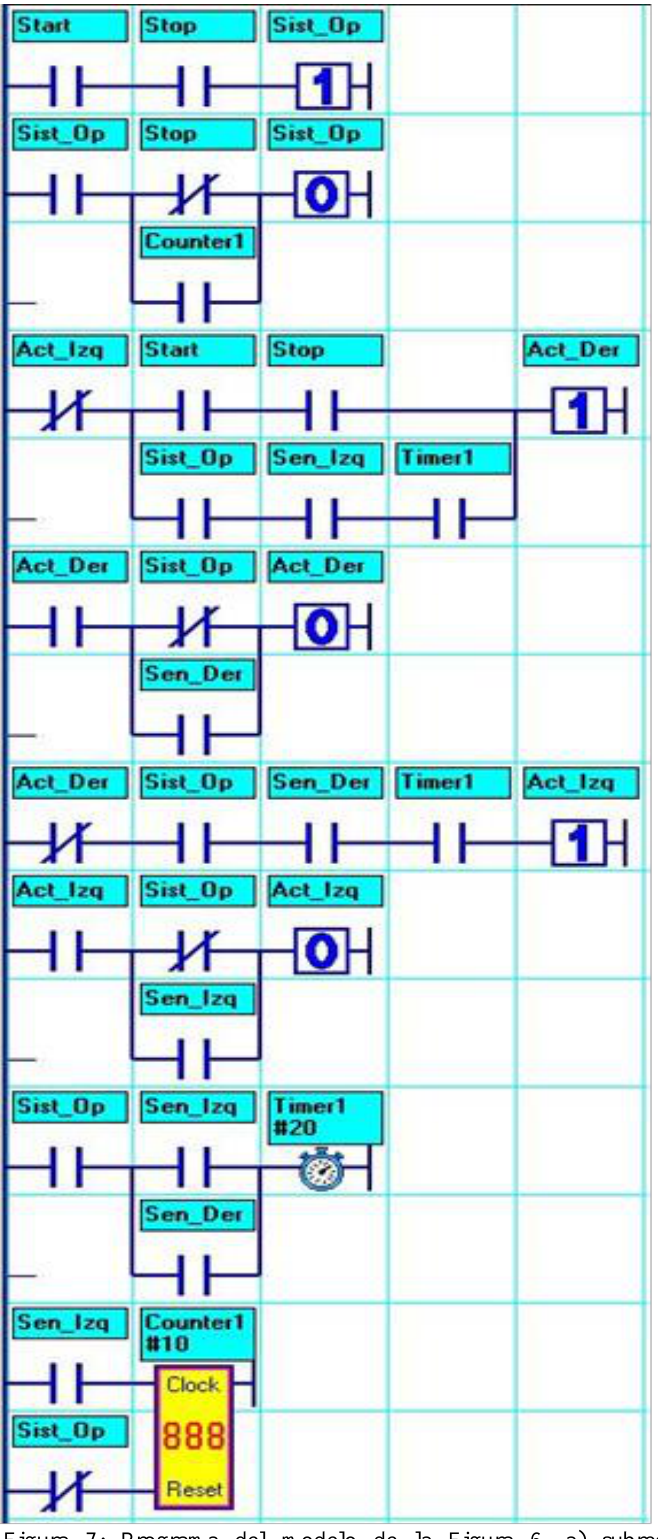
Figura 7: Programa del modelo de la Figura 6, a) subred activación del sistema, b) subred movimiento a la derecha, d) subred movimiento a la izquierda. Fuente: Autor,